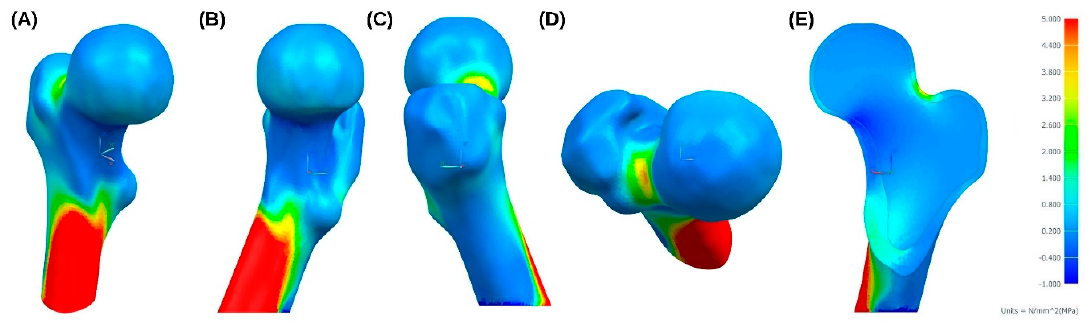
Figure 12. ( A ) Isometric, ( B ) right, ( C ) left, ( D ) top and ( E ) back view of maximum principal stress field in proximal femur when applying sitting-down loads.